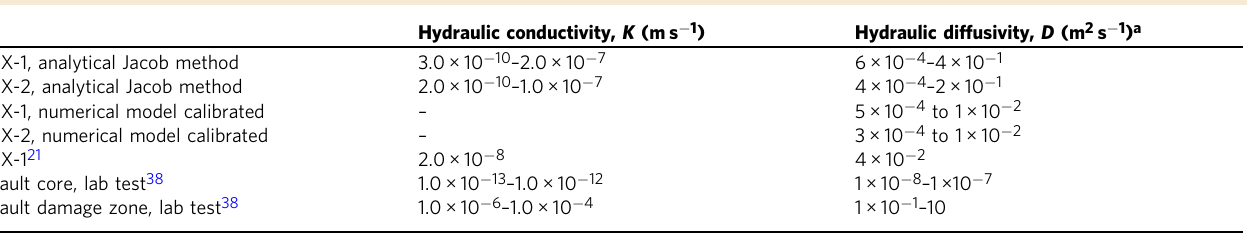
Fig. 3 Numerical model calibration of hydraulic diffusivity. Wellhead pressures are model input. Modeled and measured fl ow rate at the injection sites and the net fl ow volume are compared for a the second (total) stimulation in PX-1 and b the fi rst stimulation in PX-2. All combinations of K and S s that led to a reasonable match between modeled (solid lines) and measured data (circles) are shown. These combinations cover a range of hydraulic diffusivities as summarized in Table 1. Source data are provided as a Source Data fi le. Table 1 Summary of hydraulic conductivity and diffusivity for rocks around PX-1, PX-2, and a fault